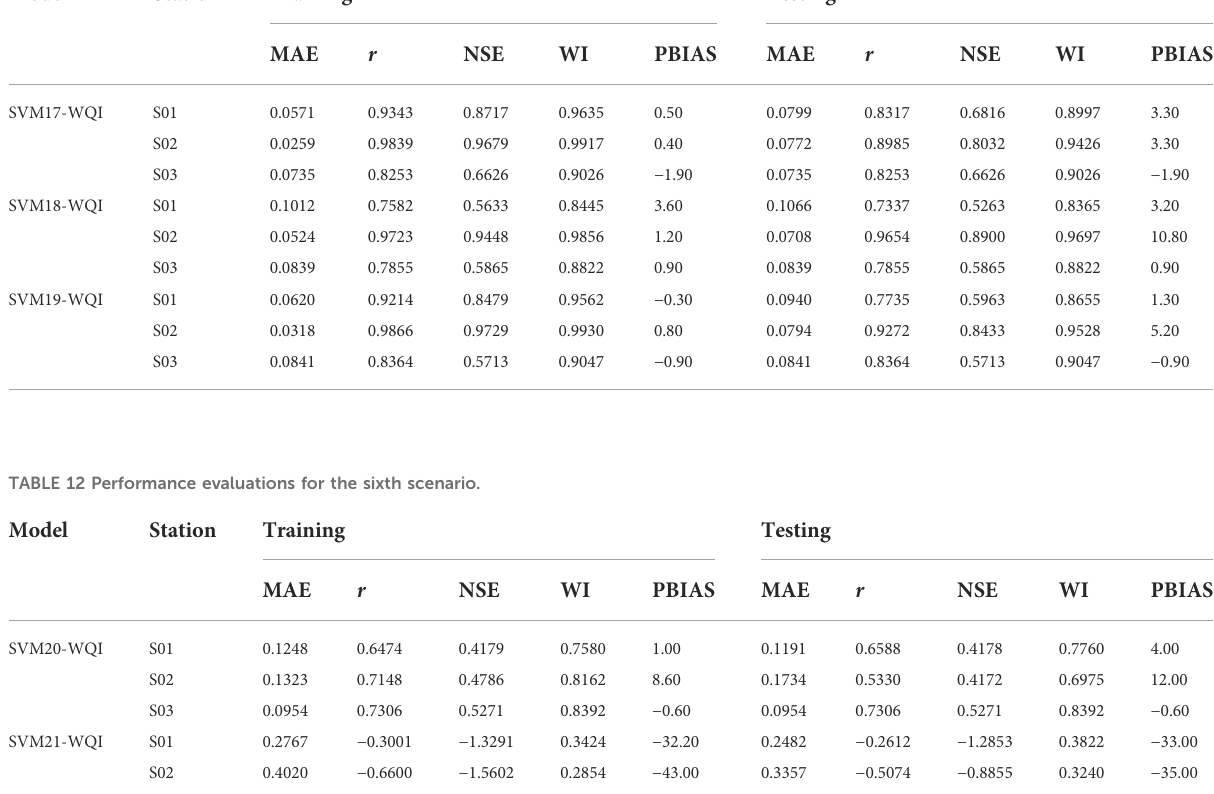
TABLE 11 Performance evaluations for the fi fth scenario. Model